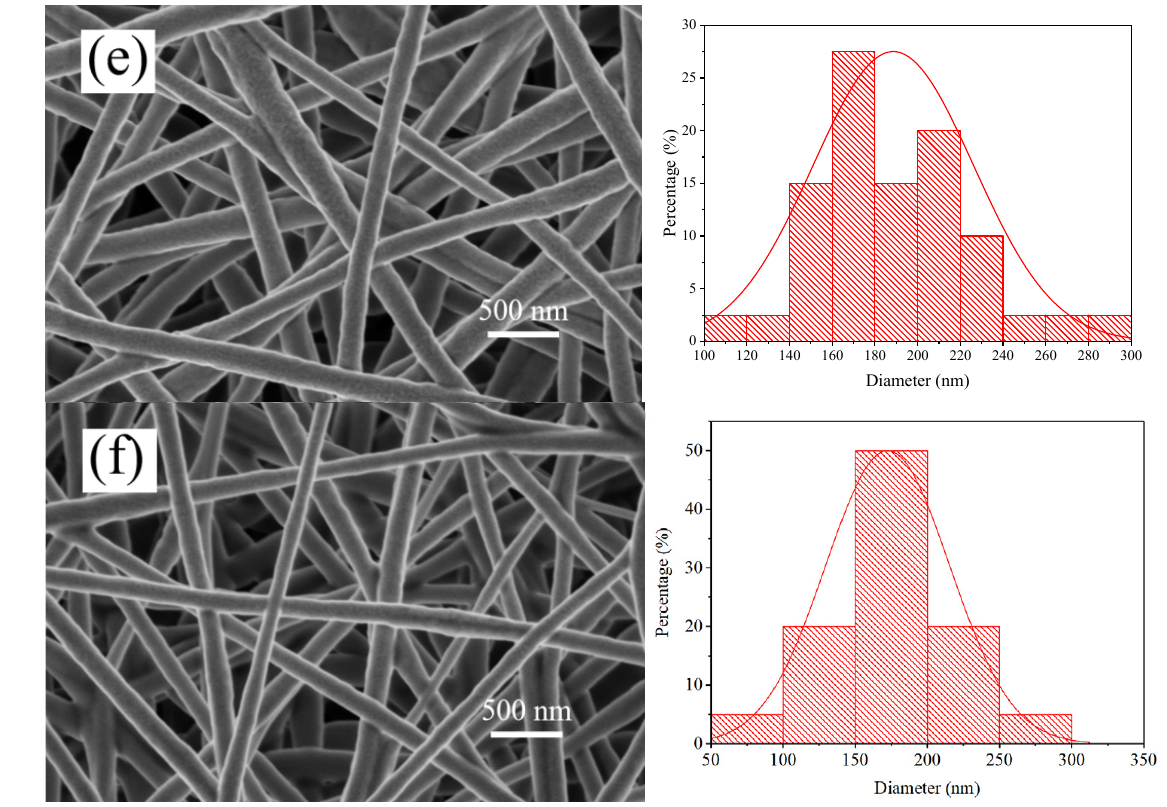
Figure 2. SEM images of urushiol/PAN nanofilm surfaces for different mass ratios: ( a ) Without urushiol (5% PAN), ( b ) 3:5, ( c ) 4:5, ( d ) 5:5, ( e ) 6:5, ( f ) 7:5.